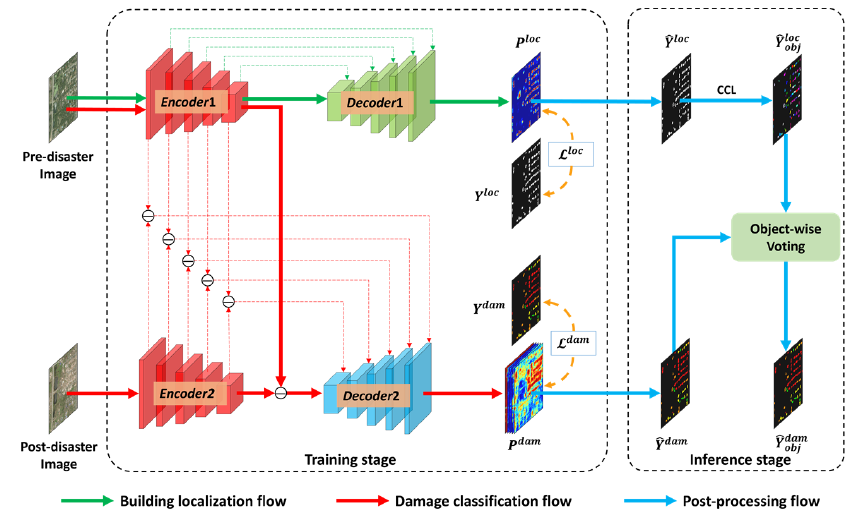
Figure 3. Illustration of multitask-based Siamese network for building damage assessment. In the training stage, pre- and post-disaster images are used to train the model for building localization and damage classification. In the inference stage, a connected component labeling (CCL) algorithm and an object-wise voting operation are adopted for object-based post-processing to refine the damage classification